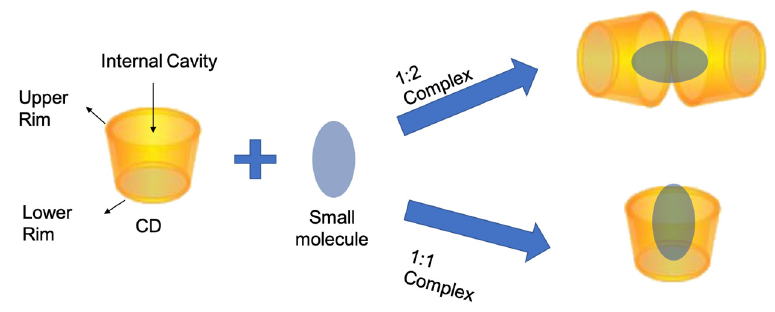
Figure 1. The schematization of CDs most common complexes.